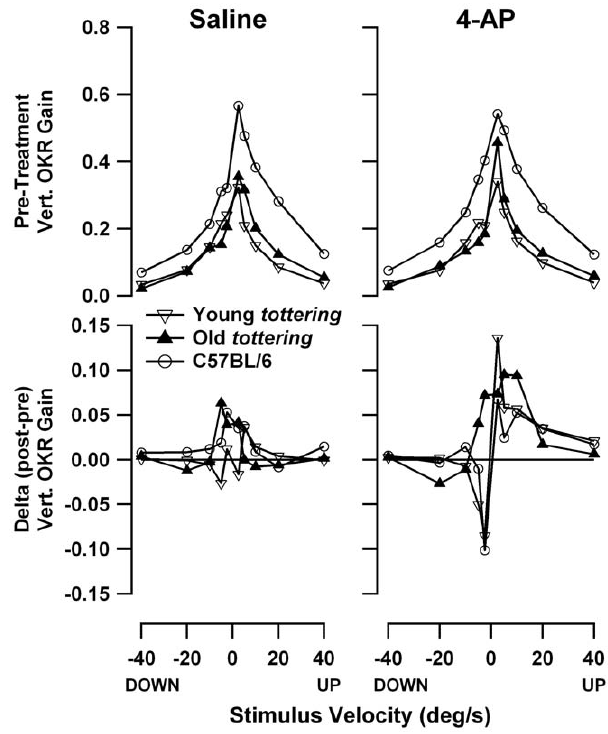
Figure 6. Speed tuning curves for yaw OKR. Top panels depict the average speed tuning curves in the pre-treatment period, with one curve for each animal cohort. Bottom curves plot the difference between average gain curves before and after treatment (post- treatment minus pre-treatment). A horizontal line indicating no change is superimposed for reference. Left panels are for saline sessions and right panels are for 4-AP sessions. All cohorts exhibited habituation, with mutants probably more affected than controls. 4-AP may have reduced the habituation mildly.